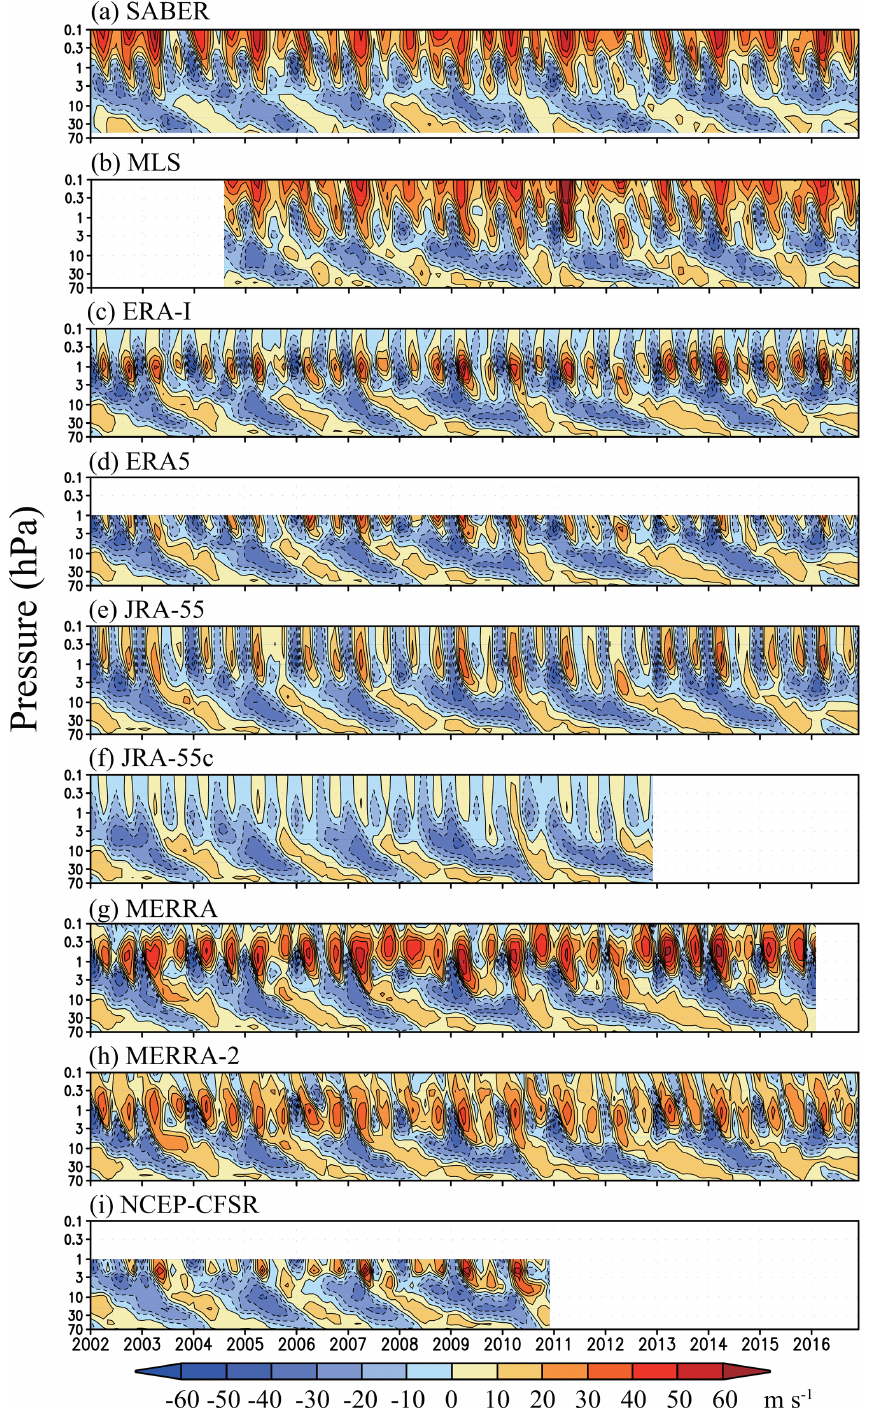
Figure 1. Time–height section of the equatorial zonal mean zonal wind in the (a) SABER and (b) MLS satellite-derived datasets as processed by Smith et al. (2017) and (c–i) each reanalysis from January 2002 to December 2016. The color intervals are 10ms − 1 .